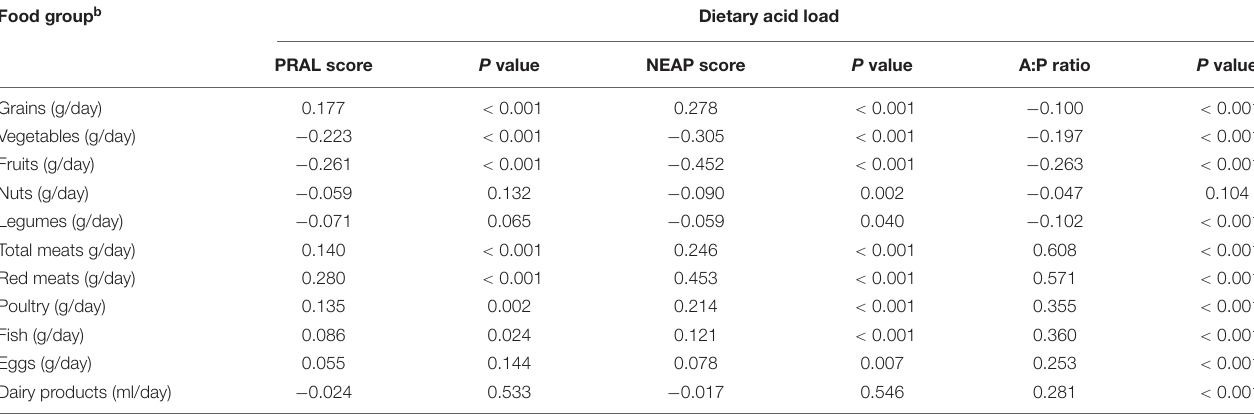
TABLE 2 | Pearson correlations between food group intake and three dietary acid load measures a . Food group b Dietary acid